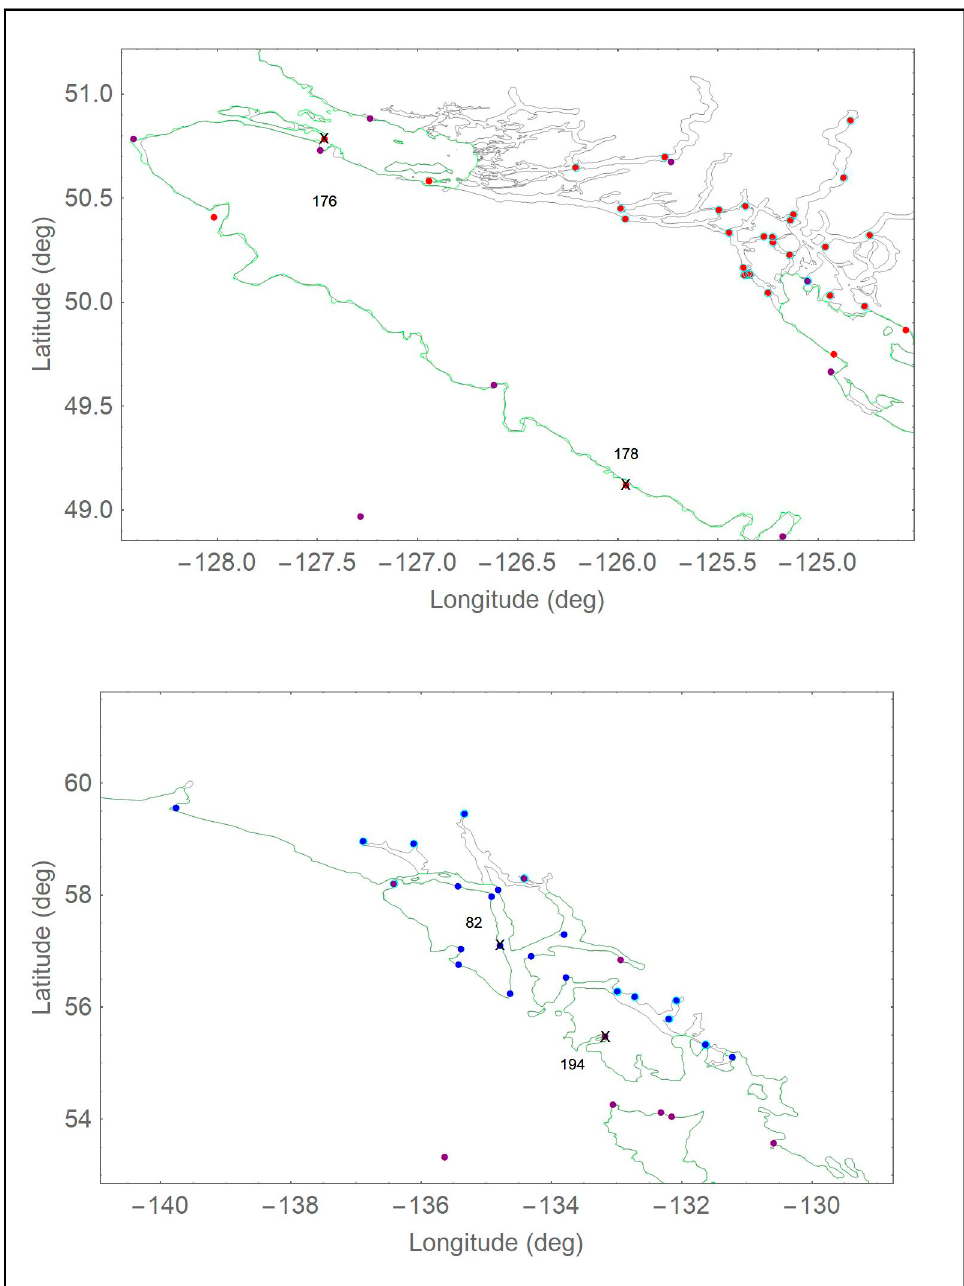
Figure A4. Location of validation stations: British Columbia and Southeast Alaska.